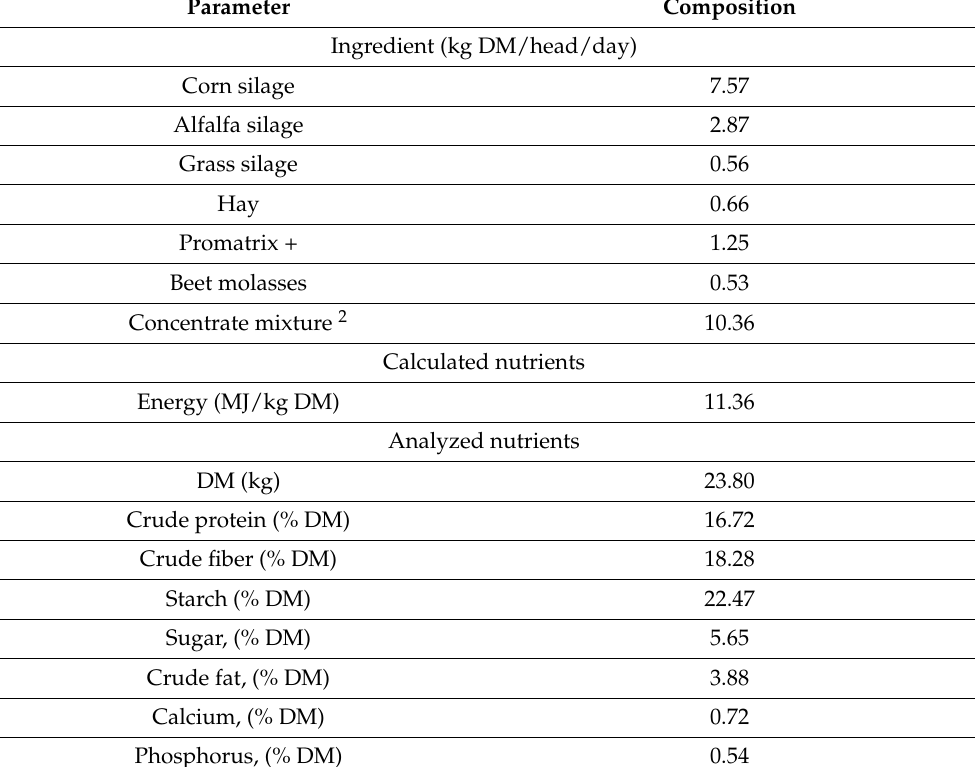
Table 1. Composition of the diet 1